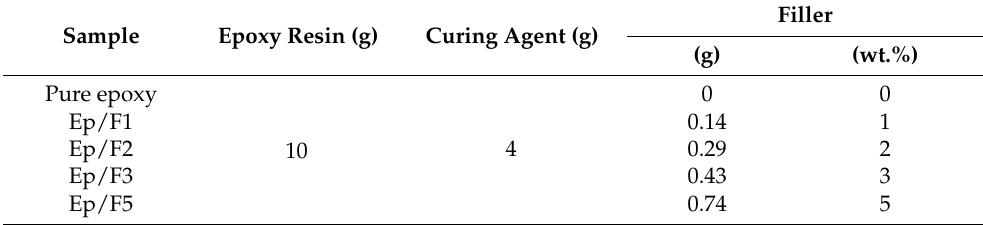
Table 1. Formulation of epoxy/fumed silica